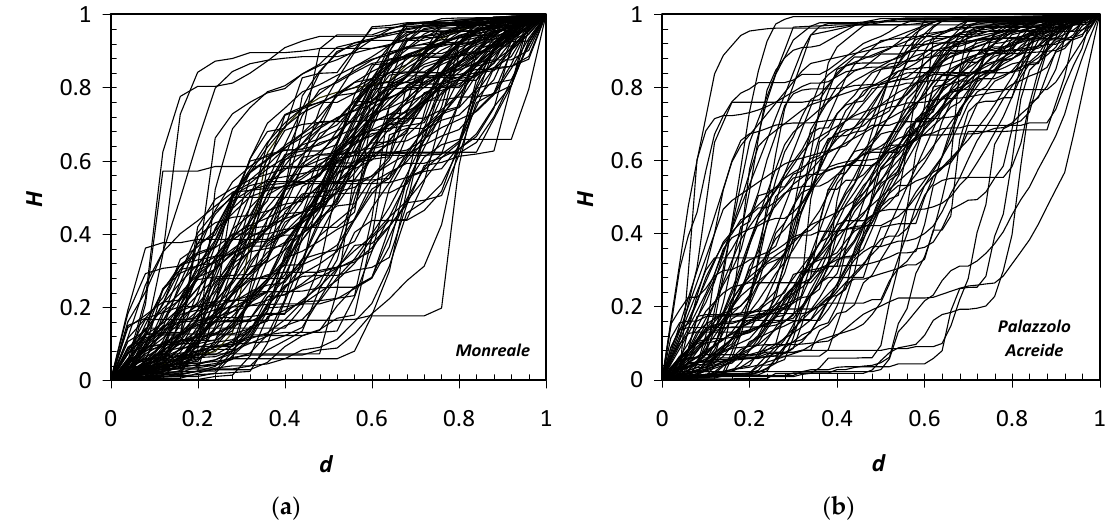
(d) Figure 6. Plotting position: ( a ) average intensity at Monreale; ( b ) duration at Monreale; ( c ) average intensity at Palazzolo Acreide; ( d ) duration at Palazzolo Acreide. 2.5. Generation of Rainfall Event Profile For the complete characterization of an event, once the main storm characteristics are generated, it is necessary to establish the rainfall event profile. To this aim, the concept of mass curves, defined as normalized cumulative storm depth versus normalized time since the beginning of a storm, extensively applied by several authors [11,13,44], has been utilized. According to this theory, for an event of total duration D, average rainfall intensity I and, consequently, cumulative storm volume V = I·D, its pattern is represented by a dimensionless rainfall hyetograph defined as: 𝐻(𝑑) = (cid:2869) (cid:3023) (cid:1516) ℎ(𝑡) 𝑑𝑡 (cid:3047) (cid:2868) , (15) where t (0 ≤ t ≤ D) is the considered time interval of the event divided by the total duration and,